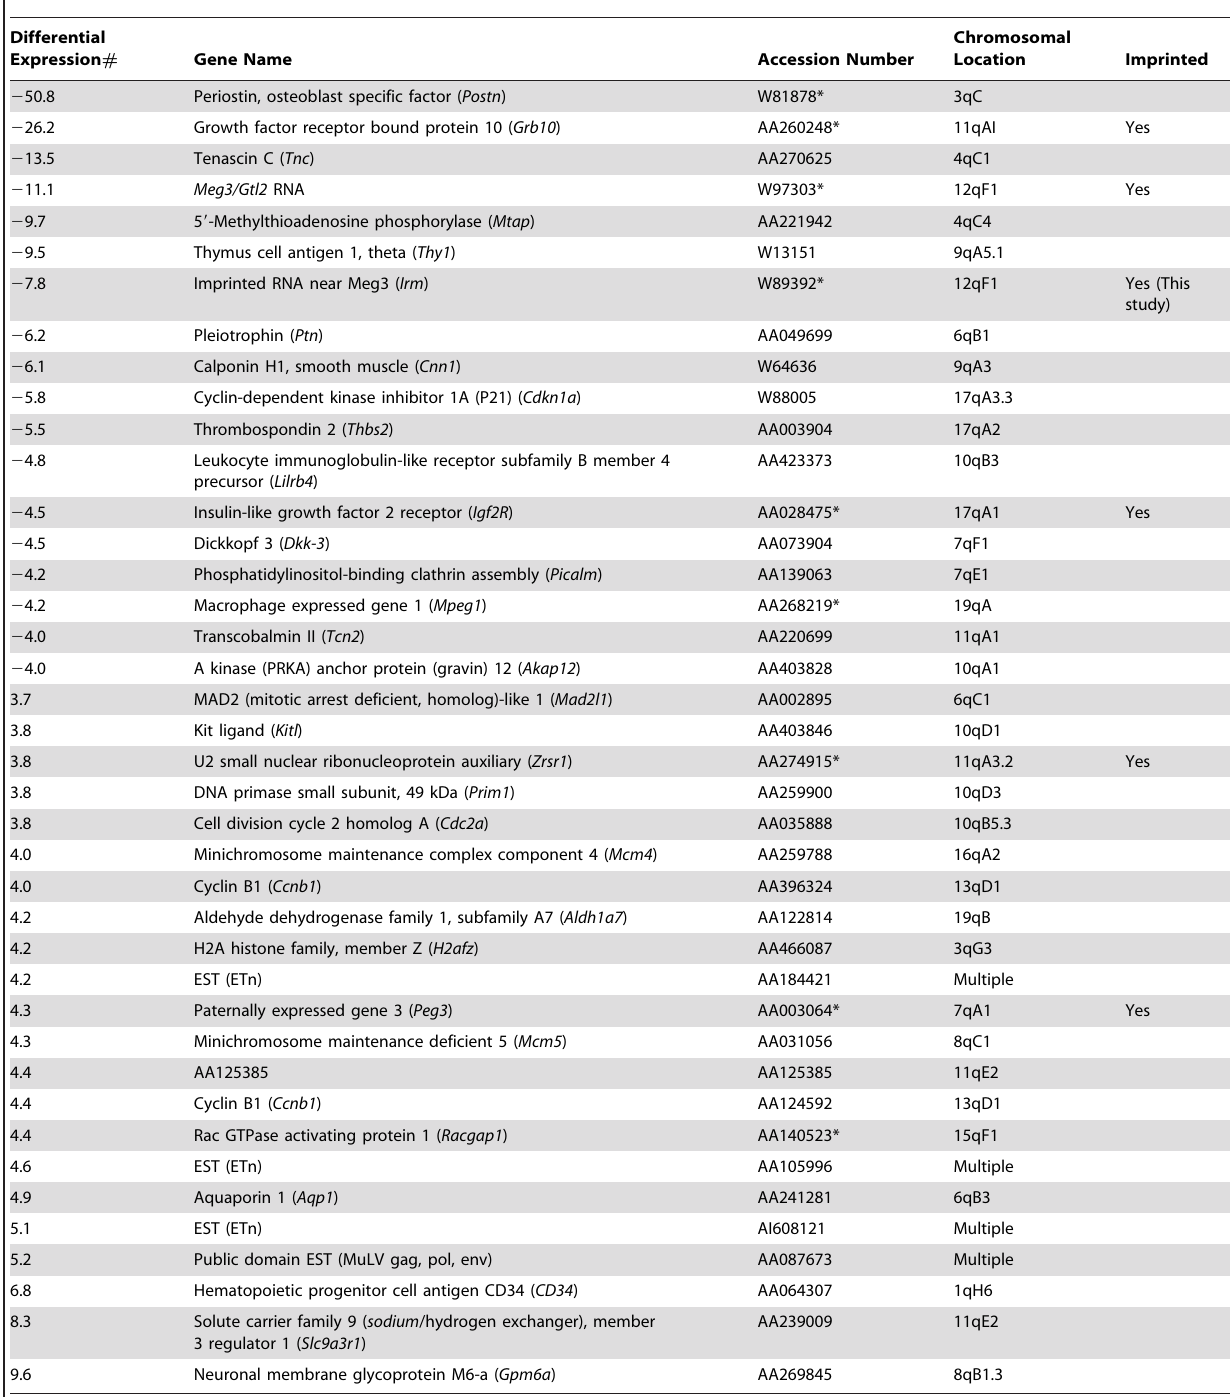
Table 1. Androgenetic versus Parthenogenetic PMEF Transcription Profiling Results Using Incyte GEM1